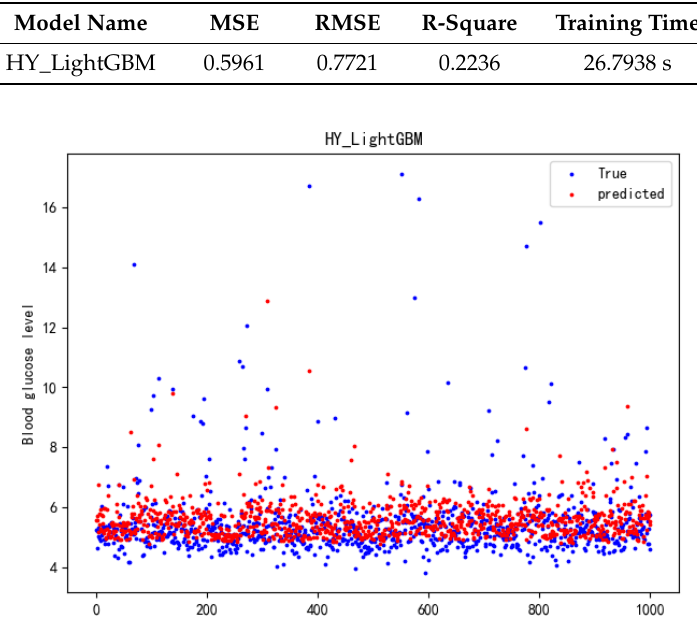
Table 3. Prediction results of HY_LightGBM model.